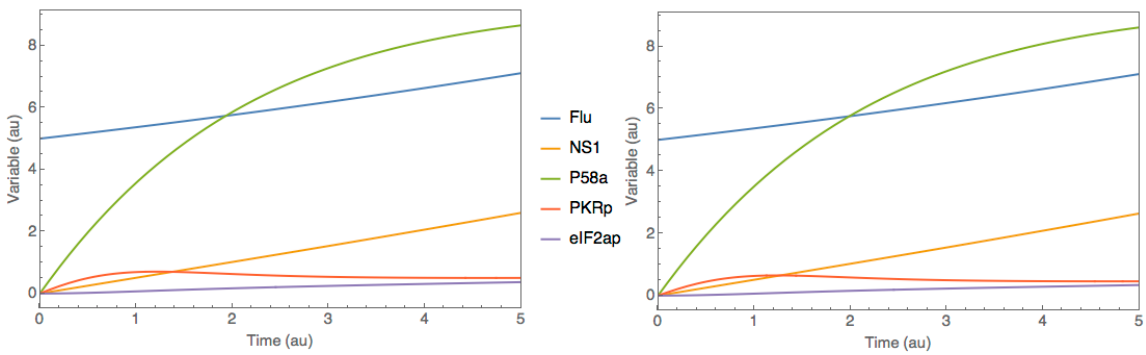
Figure 5. Comparison between original model and best hybrid model for case study 2 (P58IPK signal transduction pathway). Dynamic profiles were simulated based on the respective SBML files in the JWS Online platform. The test experiment was the center point experiment of the CC-DOE (not used for training). Full lines represent species concentrations over time. Left panel: Original SBML model simulation. Right panel: Best hybrid model simulation with structure [5 × 10 × 10 × 10 × 9] (Sixth row of Table 3).